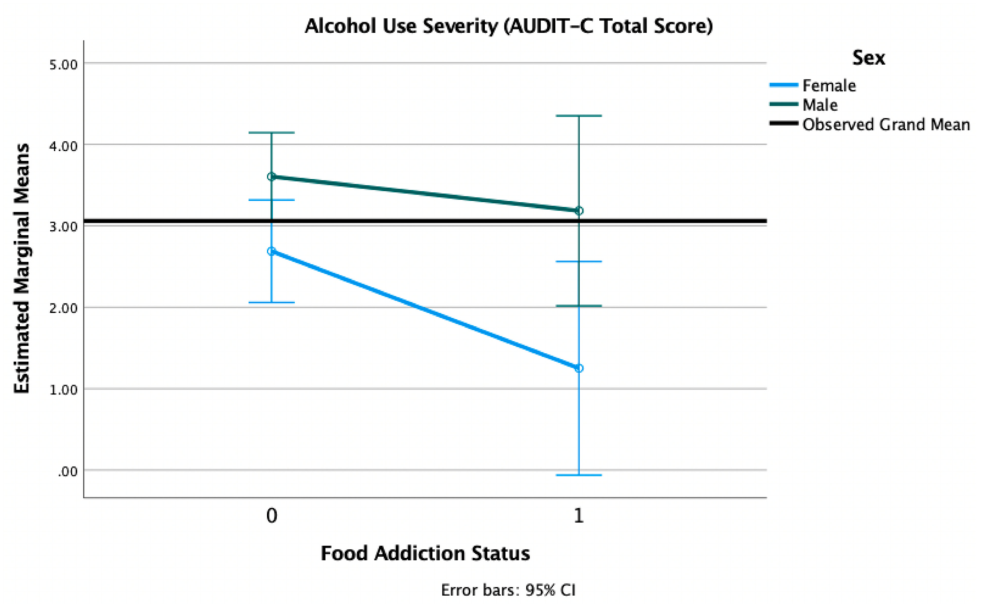
Figure 6. Estimated marginal means of alcohol use severity for a 2 × 2 factorial ANOVA with sex (female, male) and FA status (1 = positive, 0 = negative, on the X -axis) adjusted for age, race, and PTSD status (threshold vs. subthreshold). Note: AUDIT-C = Alcohol Use Disorder Identification Test-Consumption.